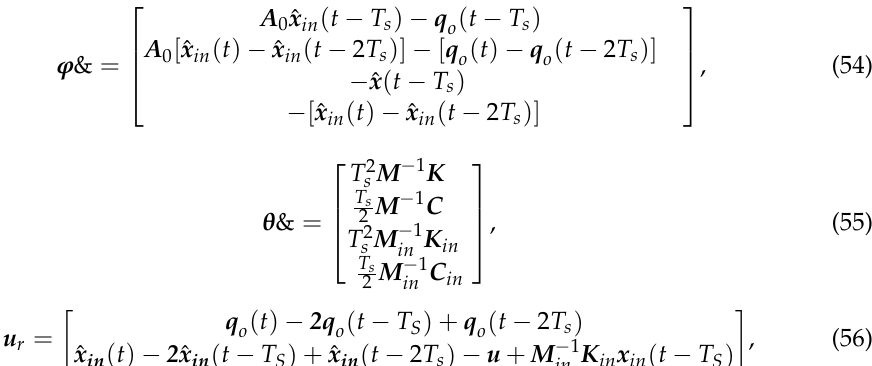
Table 4. Evaluated system parameters and controller design specifications.